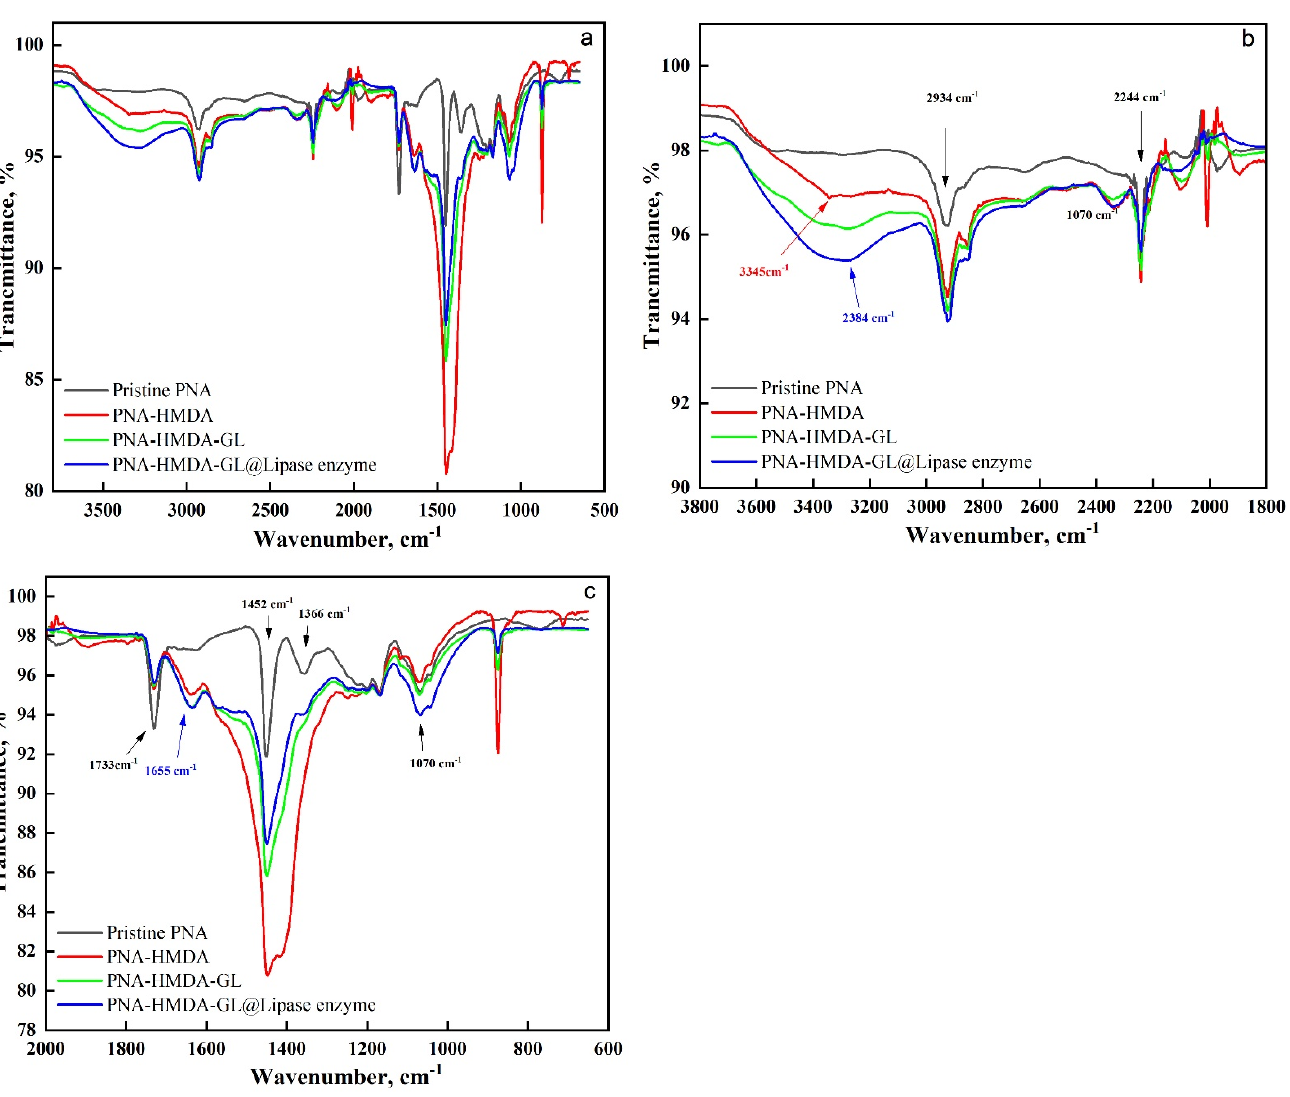
Figure 3. ATR-FTIR spectra of pristine PAN, PAN-HMDA, PAN-HMDA-GL, and PAN-HMDA- GL@Lipase ( a -full scale, b , c -expanded scale).